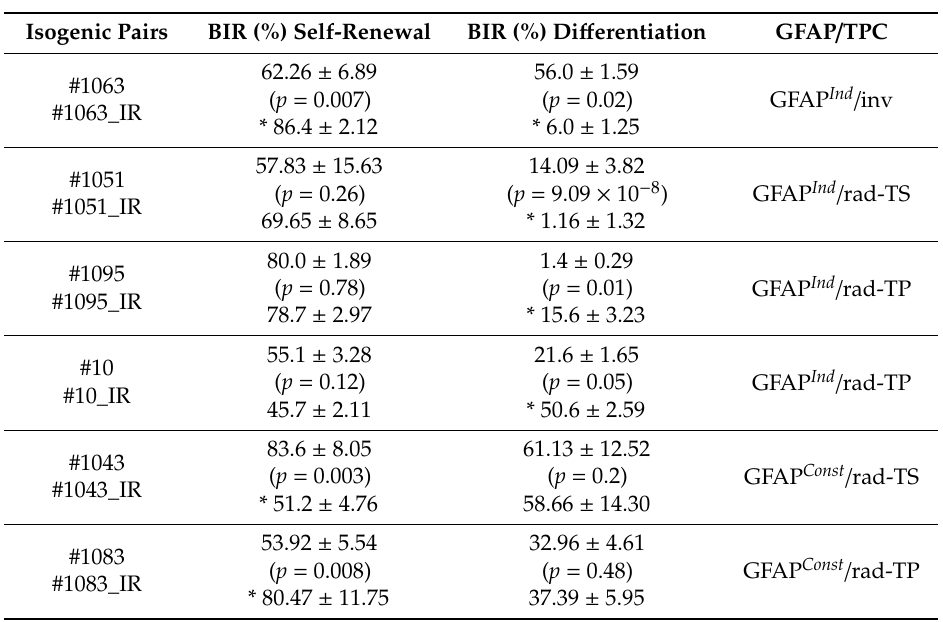
Figure 4. Diverse patterns of change in the tumor-propagating capacity of GSCs after hypofractionated radiation. Survival analyses in mice implanted by isogenic GSCs, either non-radiated (black curves) or after fr-IR (red curves). Table 2. Proliferative changes invoked by radiation in di ff erent types of